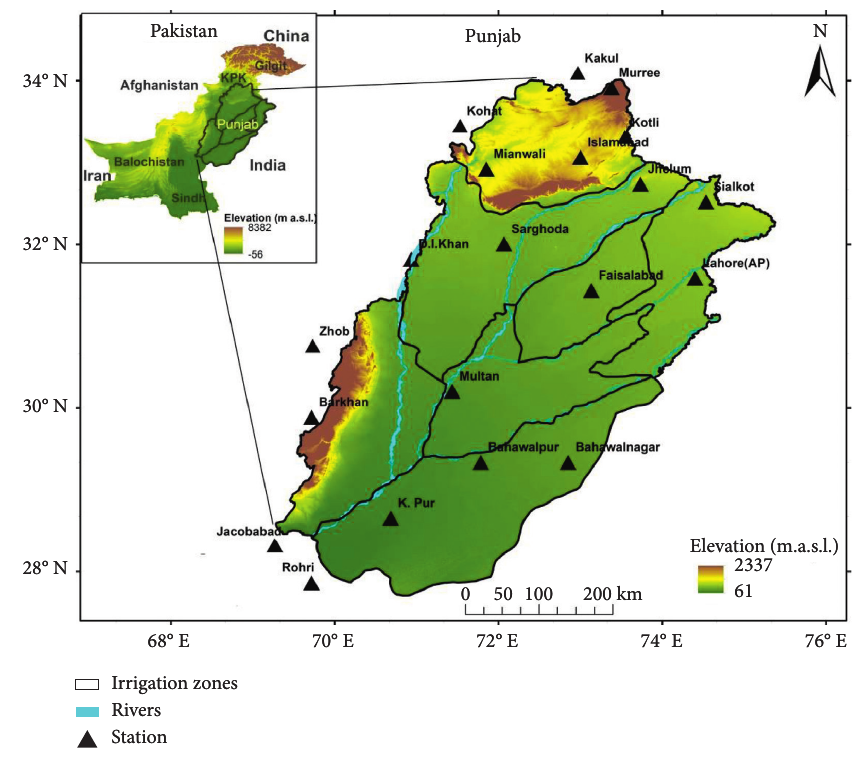
Figure 1: Location of the study area and its climatic stations. Table 1: Information on global gridded products used in the